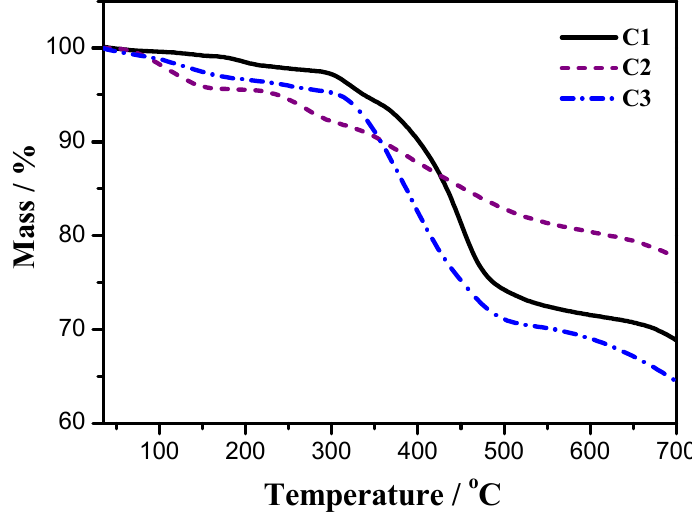
Figure 6. Thermogravimetric curves of the cationic iridium(III) complexes.